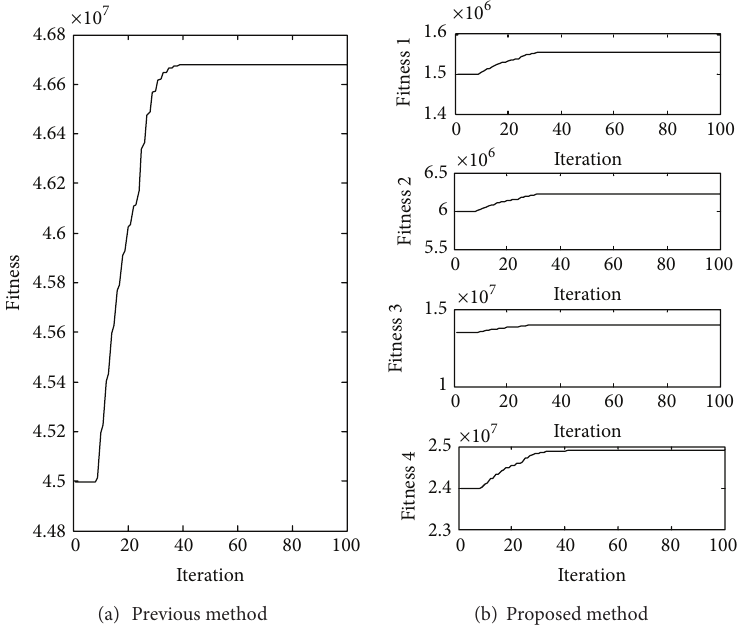
Figure 6: The fitness curves of two methods in special circumstance.